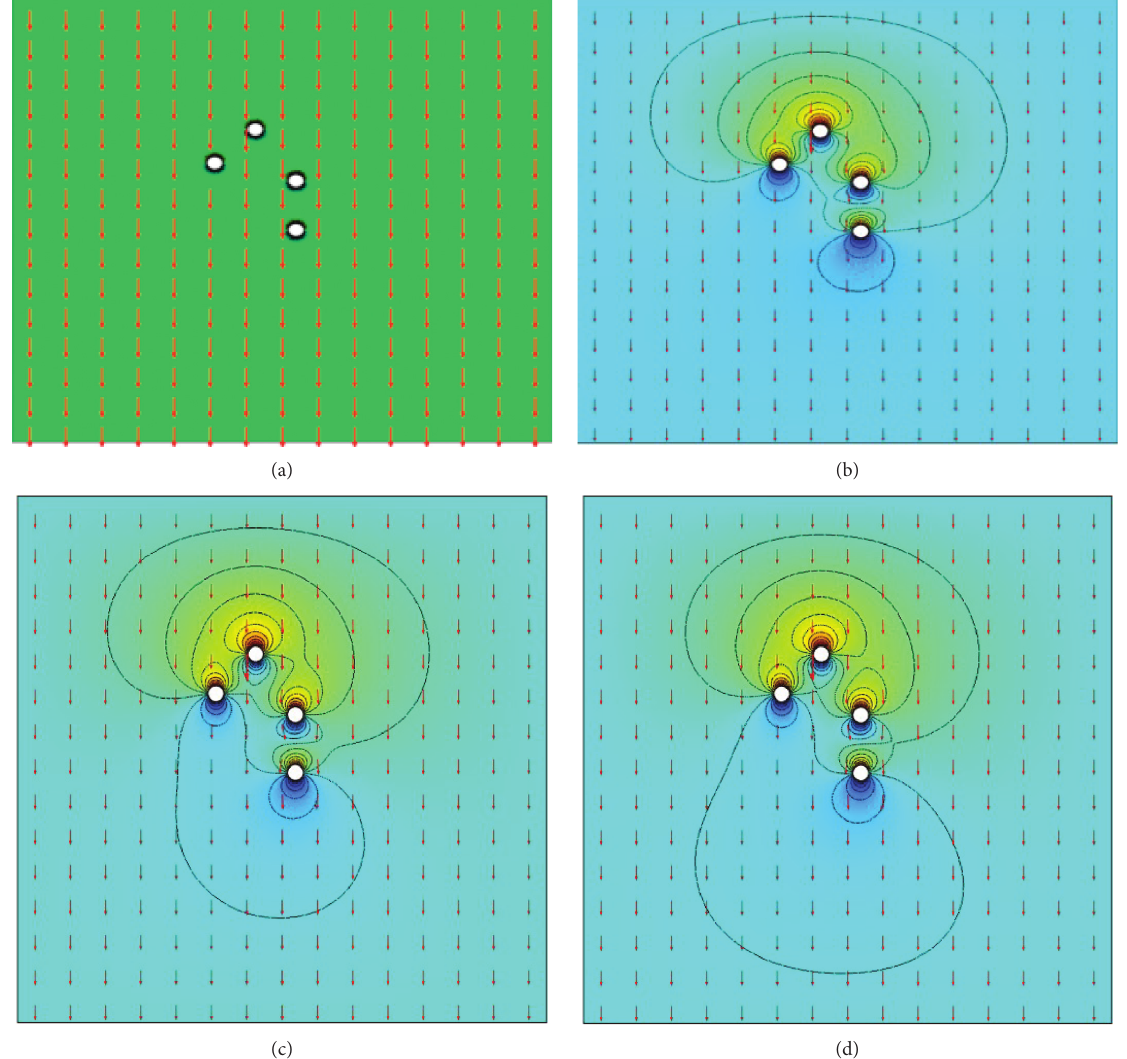
Figure 10: Diffusion law of the slurry over time. (a) The step size is 0s. (b) The step size is 60s. (c) The step size is 120s. (d) The step size is 180s.